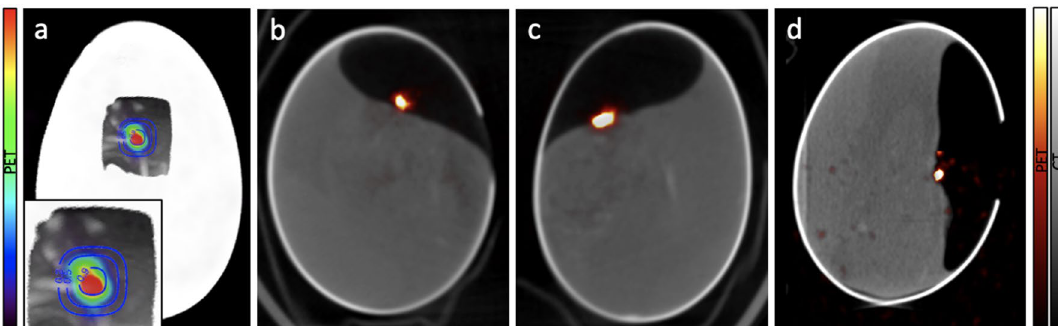
Figure 2. ( a ) Overlay of an estimation of the isodose contours of the delivered dose, the CT and the PET activation for E1. A zoomed image of the irradiated area is shown in the insert. Fused PET and CT images obtained for E1 ( b ), E2 ( c ) and E3 ( d